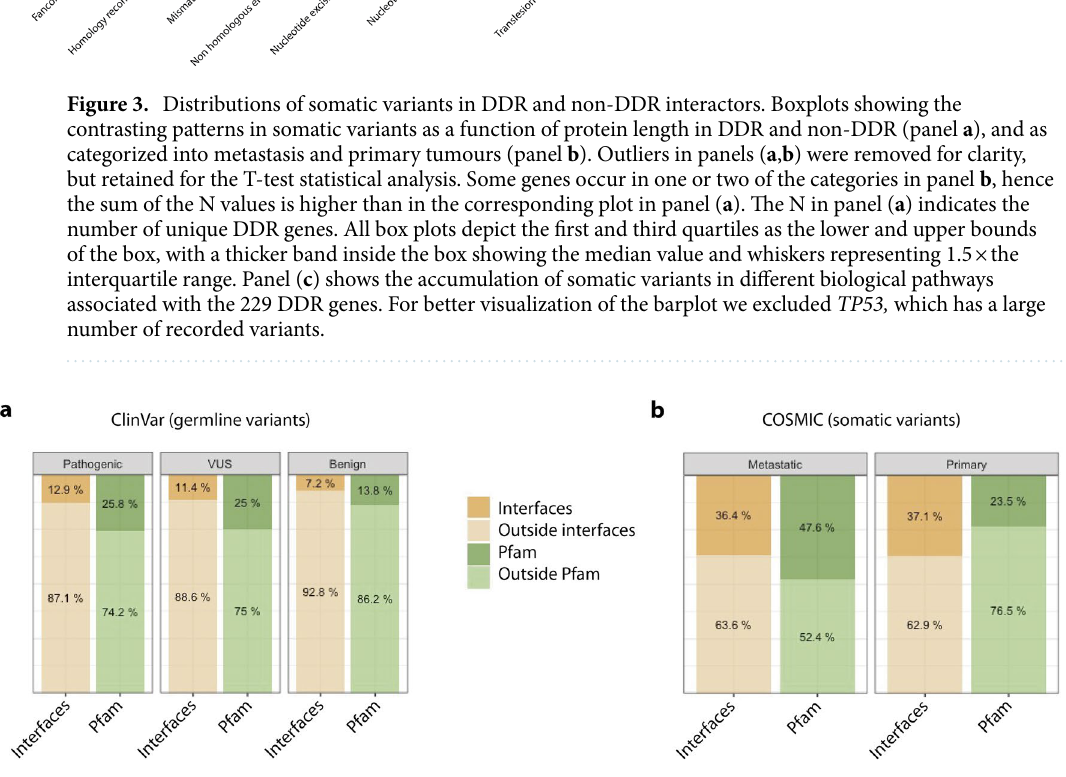
Figure 4. Accumulation of germline and somatic variants in Pfam domains and protein interaction interfaces. Panel ( a ) shows the percentage of pathogenic, VUS and benign germline variants extracted from the ClinVar database across interfaces and Pfam domains. Panel ( b ) shows the percentage of metastatic and primary somatic variants extracted from COSMIC across interfaces and Pfam